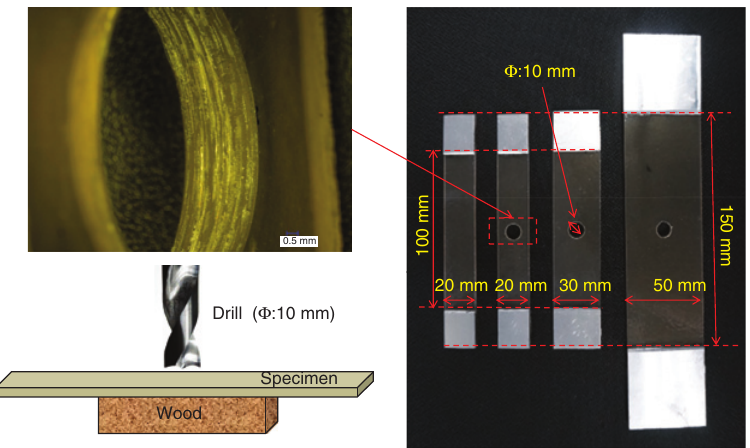
Figure 2 Dimension and preparation of